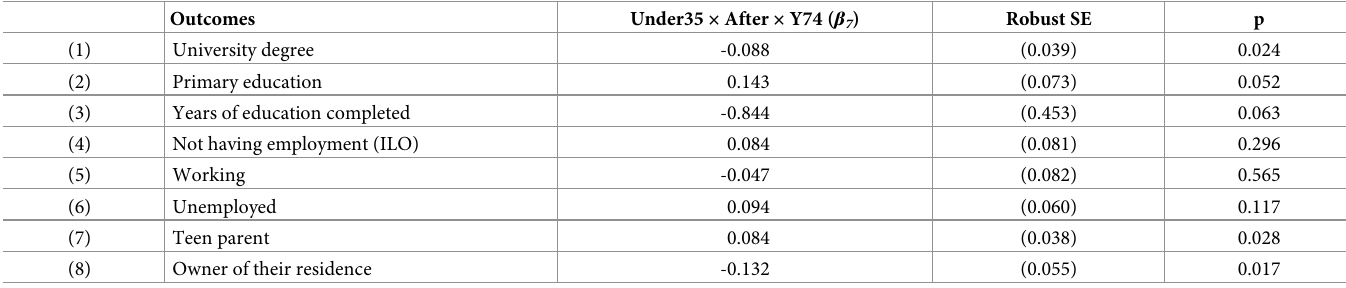
Table 2. The effect of abortion restrictions on socioeconomic outcomes, triple